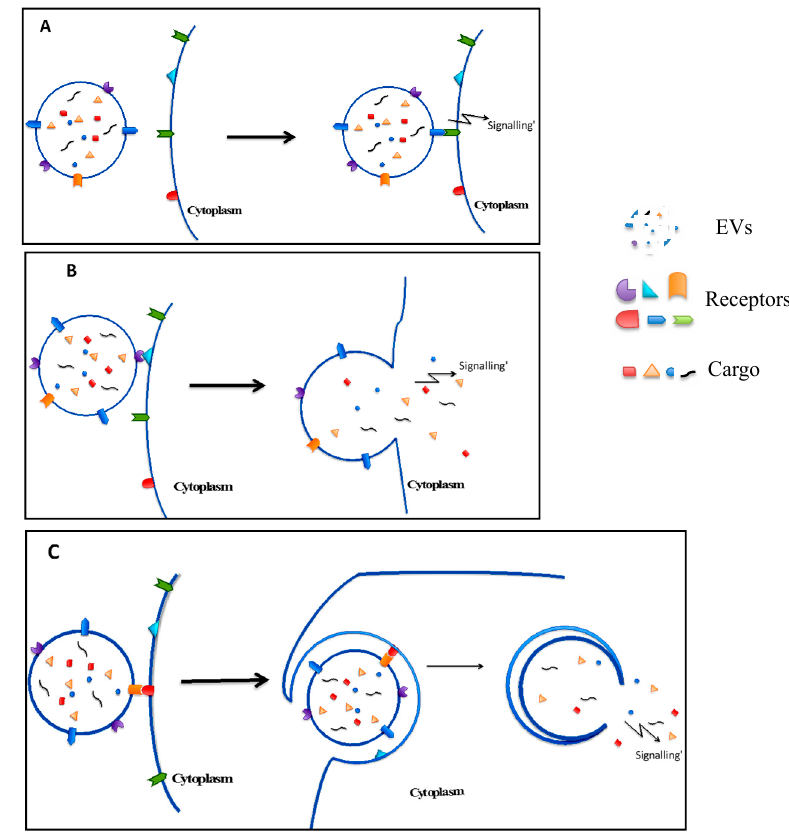
Figure 5. Interaction of EVs with target cells: ( A ) intracellular signalling due to EV membrane ligand cell surface receptor interactions [53,54]; ( B ) direct membrane fusion which induces cell function through release of EV cargo into target cells [55–58]; and ( C ) internalisation of EVs into target cells, prior to the release of their cargo into the recipient cell cytoplasm inducing functional effects [21,59].